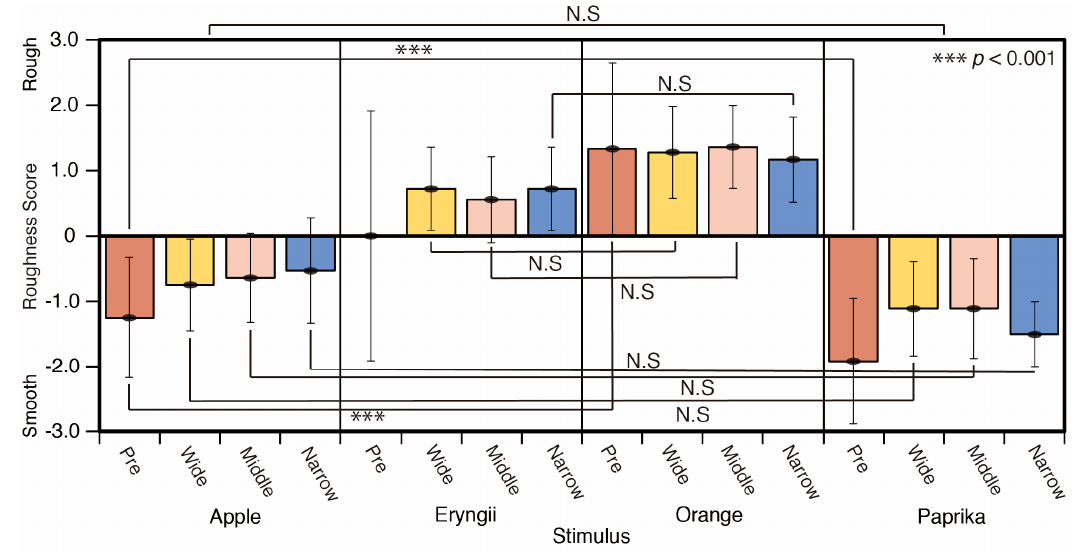
Figure 13. Roughness scores and stimuli.